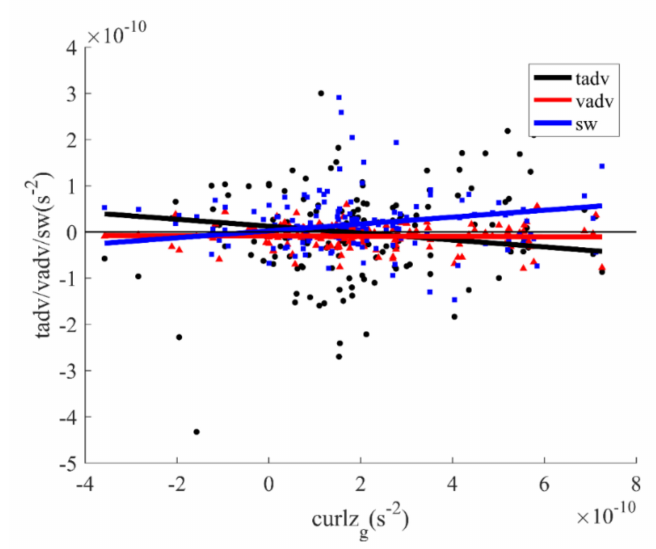
Figure 13. Scatter plots of the TADV term and the vorticity tendency (black dots), the VADV term and the vorticity tendency (red dots), and the ADIA term and the vorticity tendency (blue dots) based on the cyclones in the Northwest Pacific. The solid lines are the linear regressions.